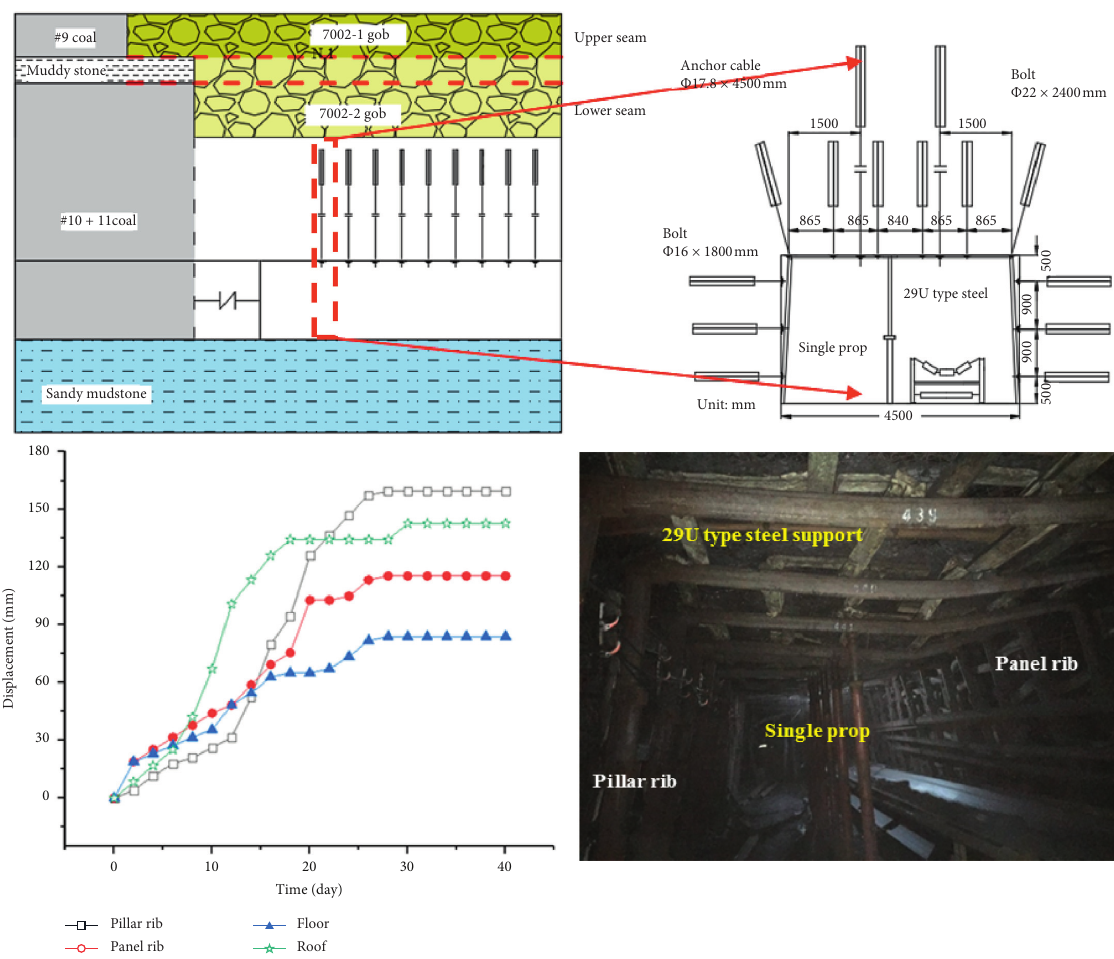
Figure 21: Roadway combined support scheme.